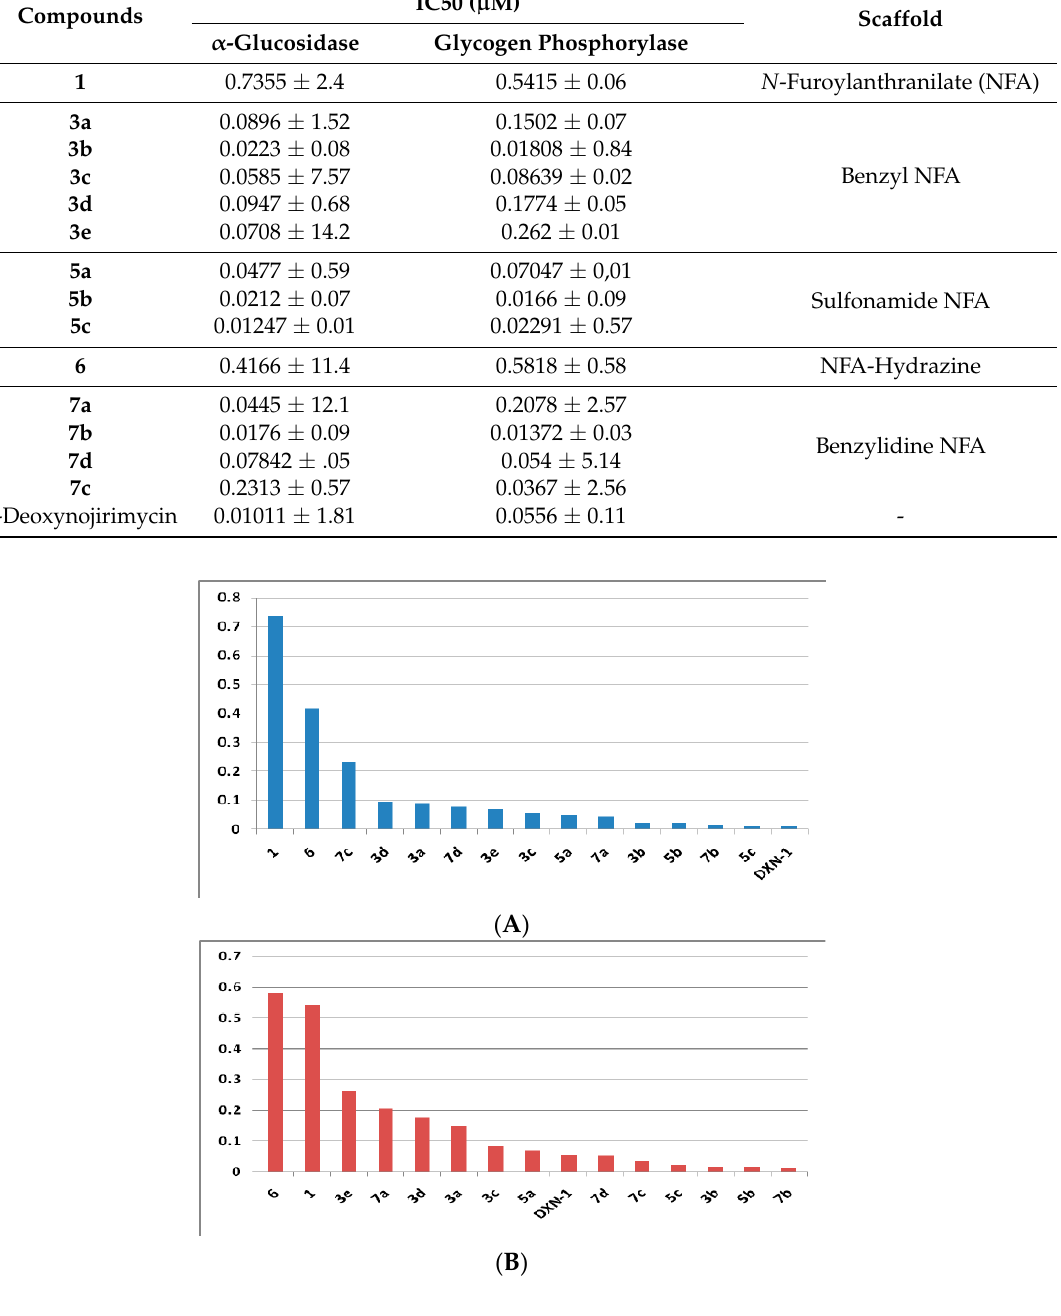
Figure 2. Bar chart of the inhibitory activity data of target compounds sorted from lowest activity to highest against two antidiabetic drug enzymes compared to the reference drug: ( A ) α -glucosidase; ( B ) glycogen phosphorylase.